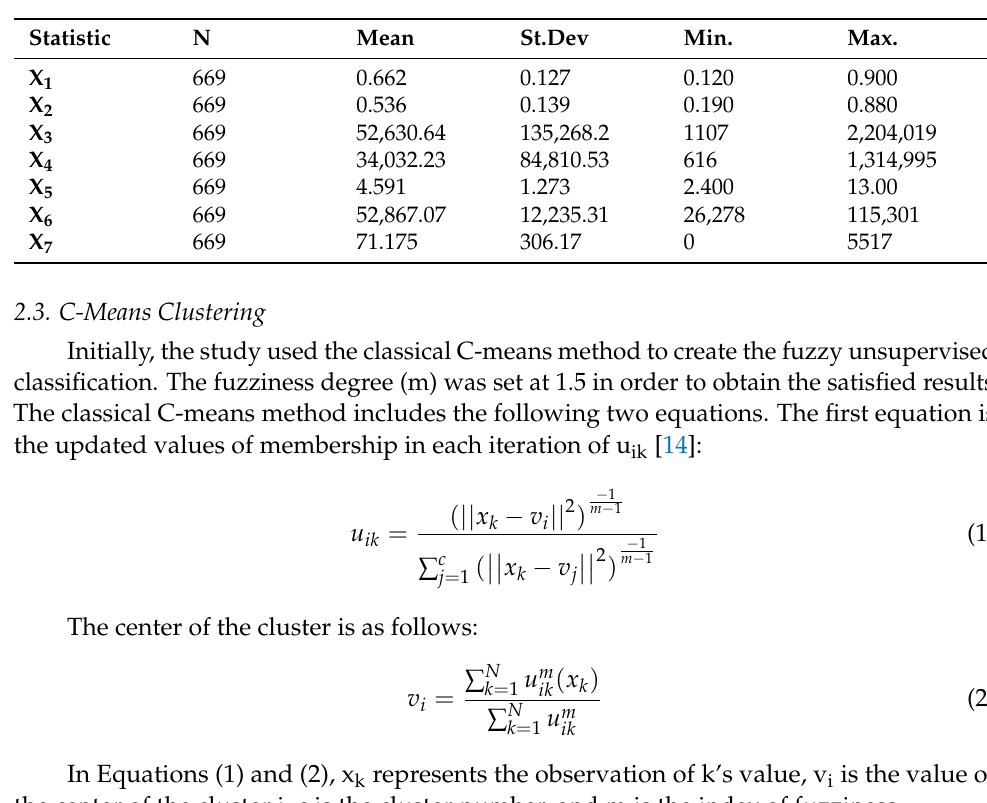
Table 2. Descriptive statistics of all